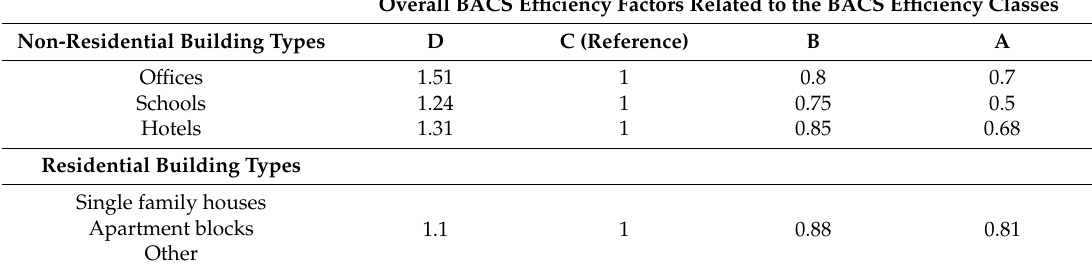
Table 3. The selected overall BACS efficiency factors—non-residential and residential